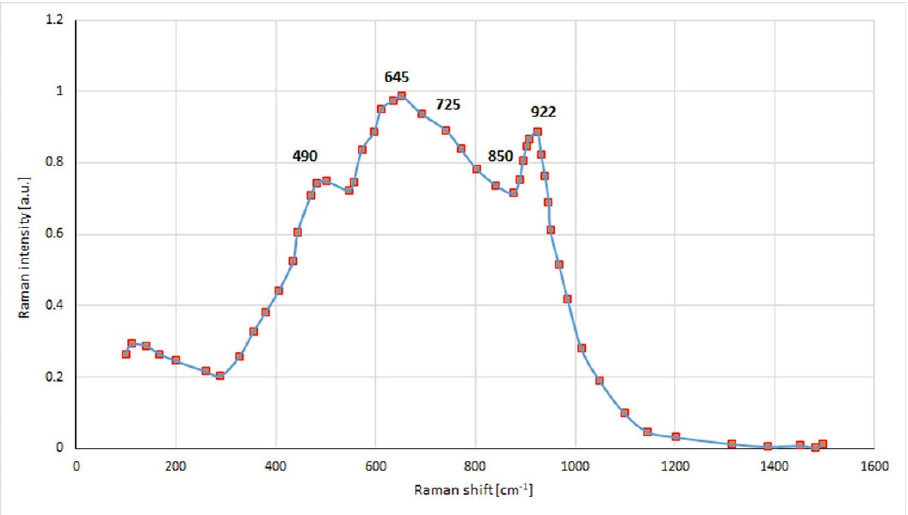
Figure 12. Raman spectra of the tungsten-tellurite glass recorded inside (red squares) and outside (blue line) the waveguide.